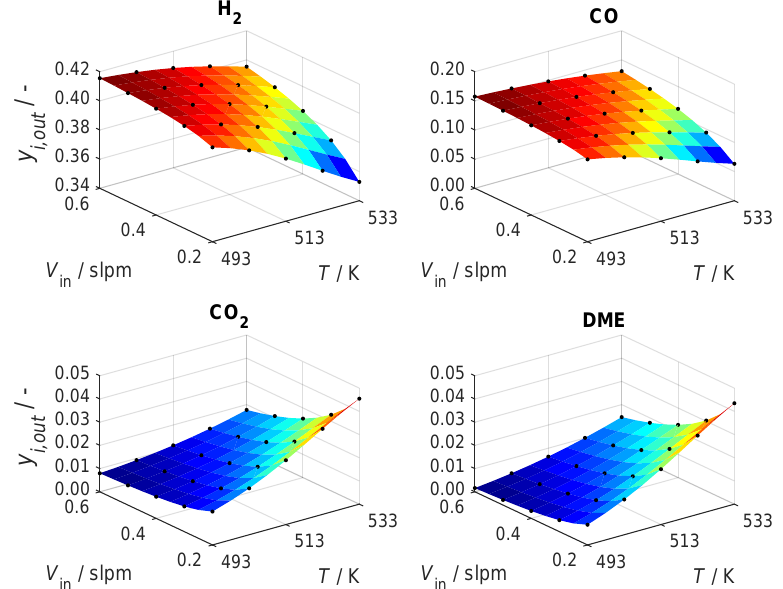
Figure 8. Surface response for the hybrid model predictions of the mole fractions of H and DME within the validity range of the temperature and total gas flow. The black points represent the conditions at which the data for model development were measured. Feed composition: 42.33% H , 16.14% CO, 0.82% CO . Pressure 50 bar. CZA-to- γ -Al 2 2